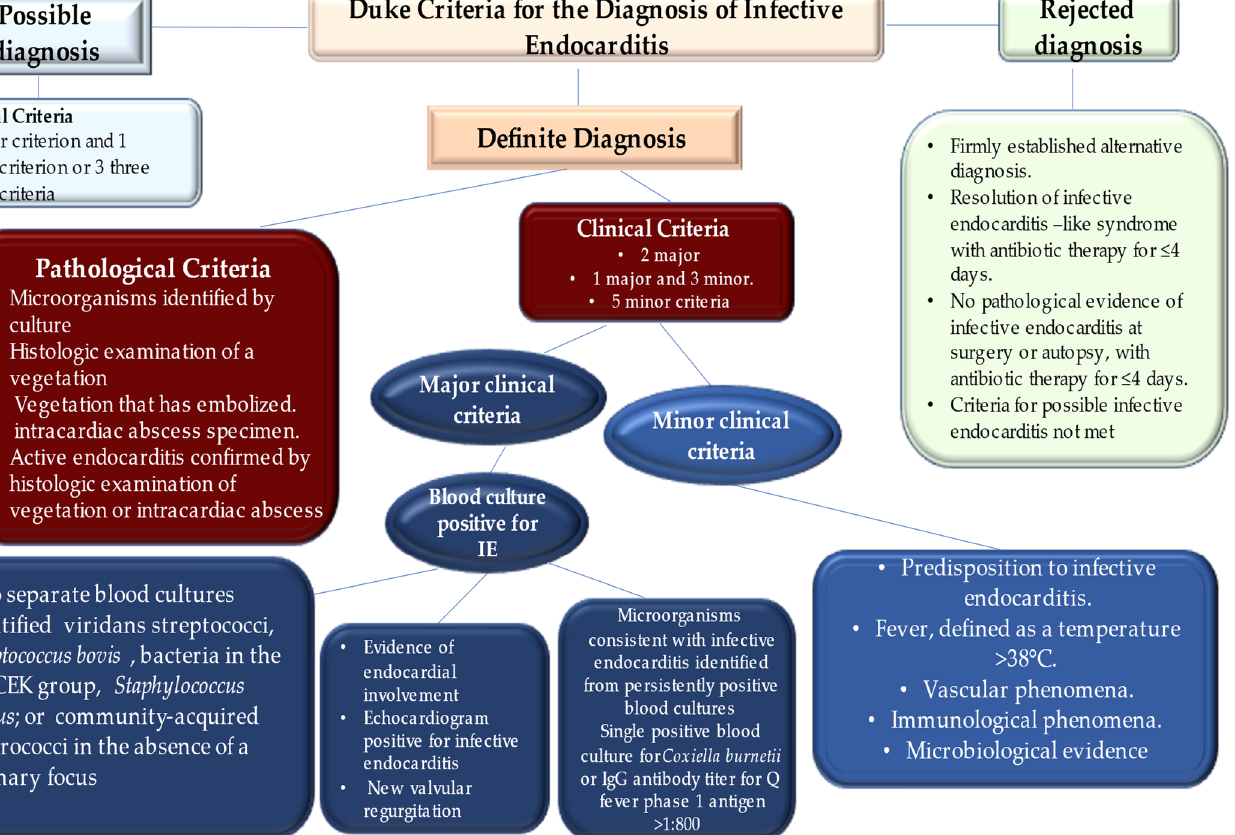
Figure 1. Depiction of Duke criteria for the diagnosis of infective endocarditis. HACEK indicates haemophilus species, Aggregatibacter (formerly Actinobacillus ) actinomycetemcomitans , Cardiobacterium hominis , Eikenella corrodens , and Kingella kingae . For patients who have prosthetic valves and possible infective endocarditis according to clinical criteria, transoesophageal echocardiography is recommended. For patients with native valve endocarditis, transthoracic echocardiography is recommended.